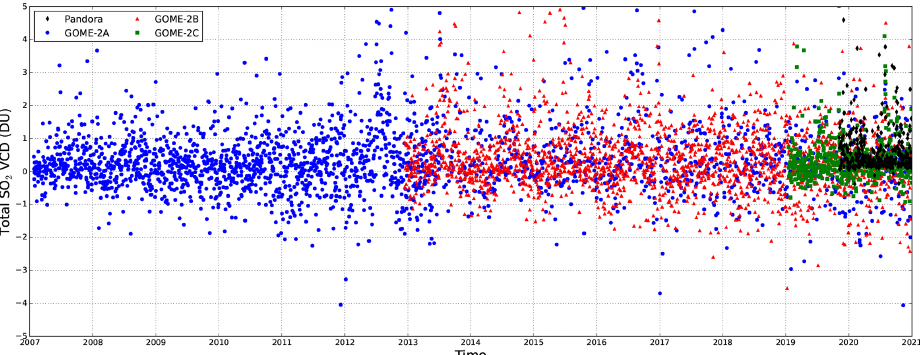
Figure 27. Time series of total column SO 2 measured by GOME-2A (blue), GOME-2B (green), GOME-2C (red), and Pandora (black) at Mexico